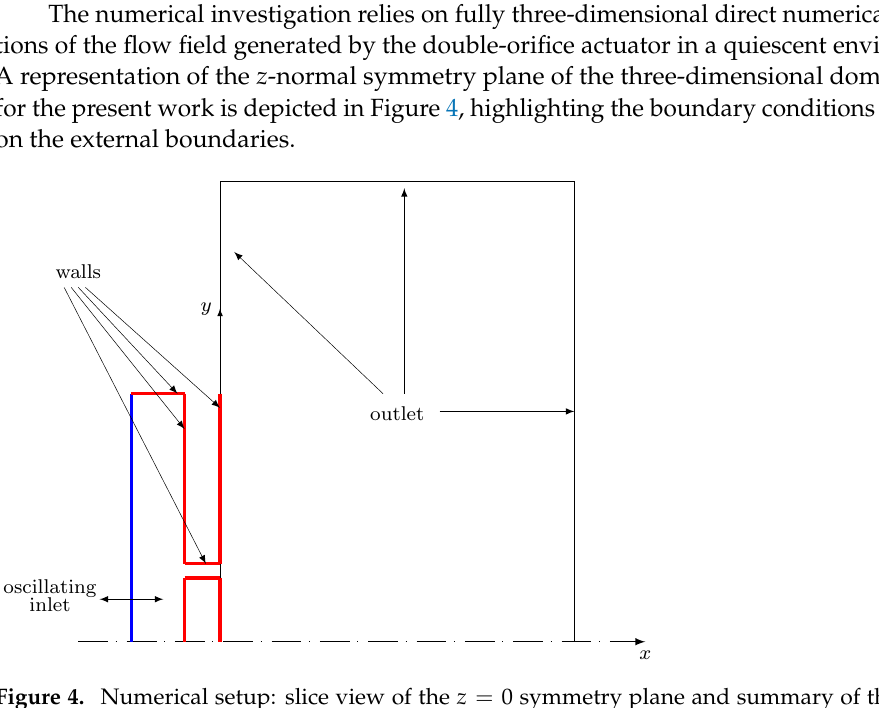
Figure 4. Numerical setup: slice view of the z = 0 symmetry plane and summary of the bound- ary